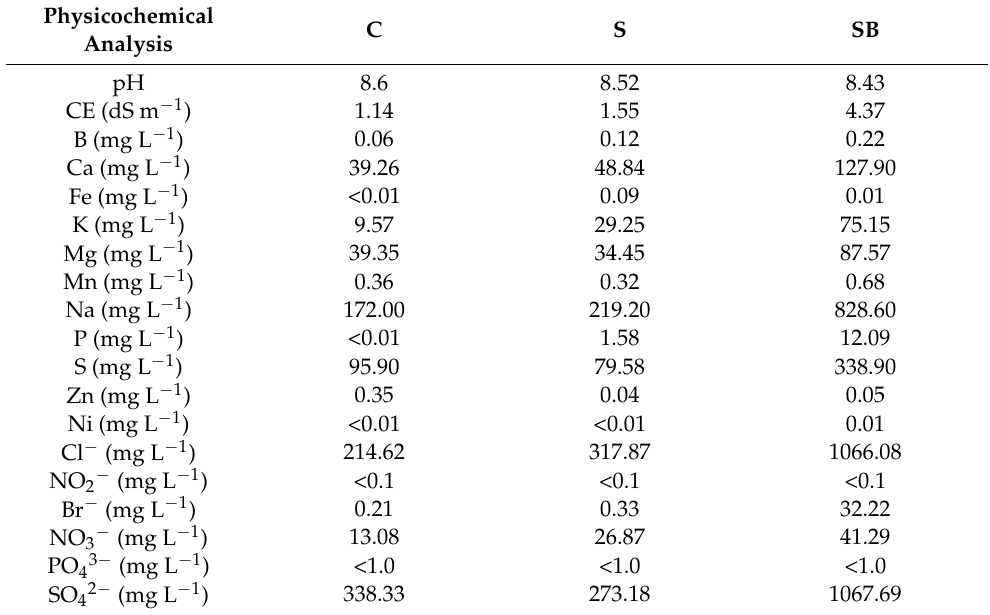
Table 6. Physicochemical analysis of irrigation water from different sources (control, C; secondary effluent, S; and secondary effluent with brine, SB). Data are values from samples collected at the beginning of the